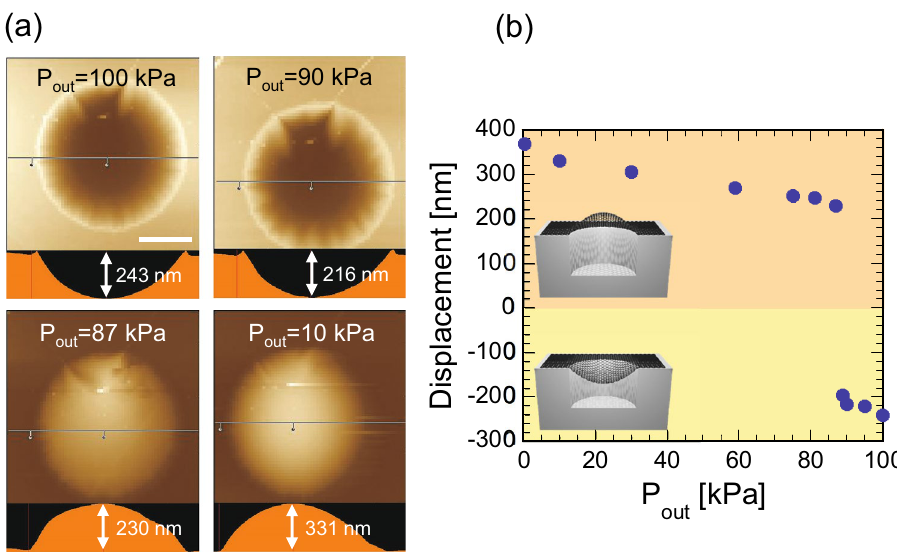
Figure 3. ( a ) Top and cross-sectional views of AFM images of the graphene drum for DEVICE 1 at various pressures P out . Bar in the image is 5 μm. ( b ) Displacement of the graphene drum at the various P out , showing the discontinuity from the downward to the upward